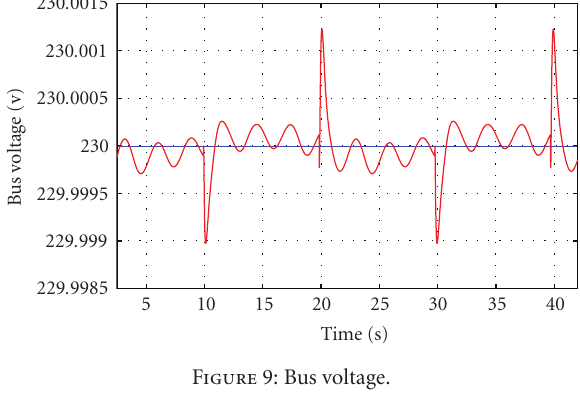
Figure 9: Bus voltage.